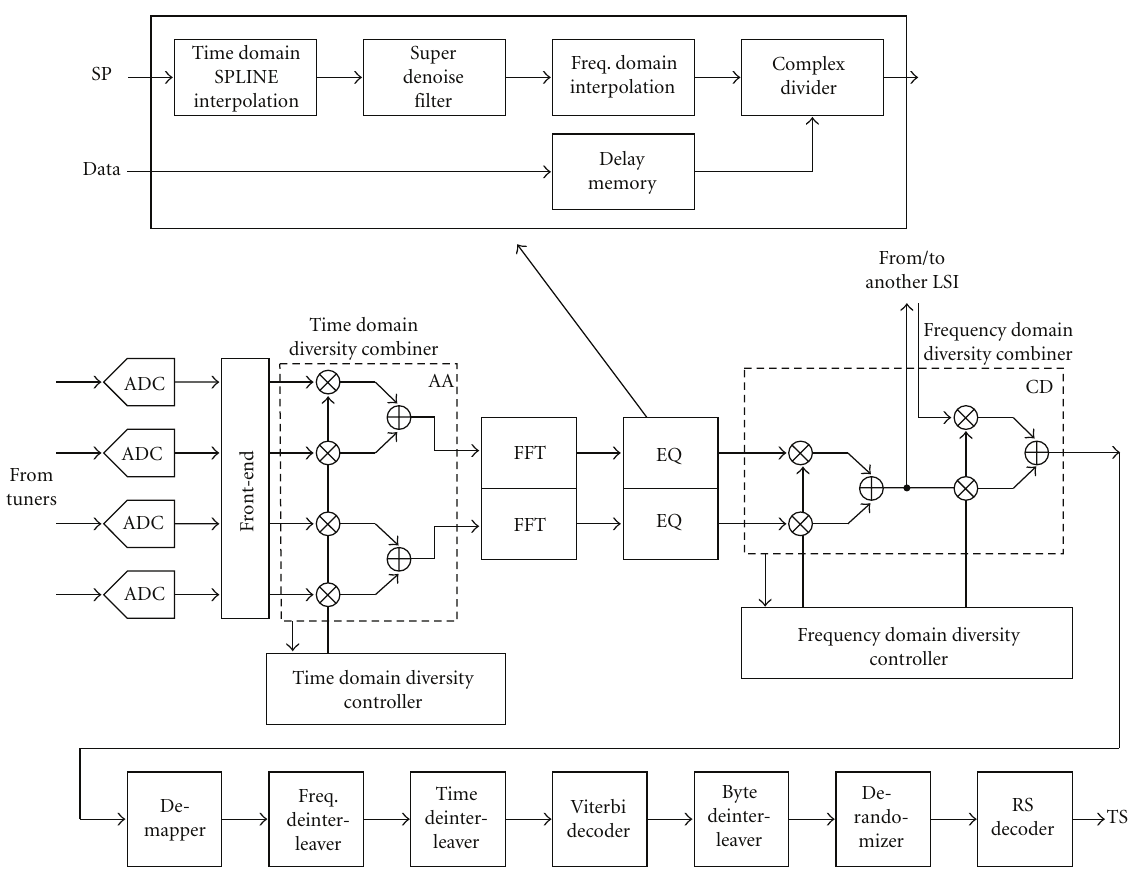
Figure 6: Detailed block diagram of receiver.